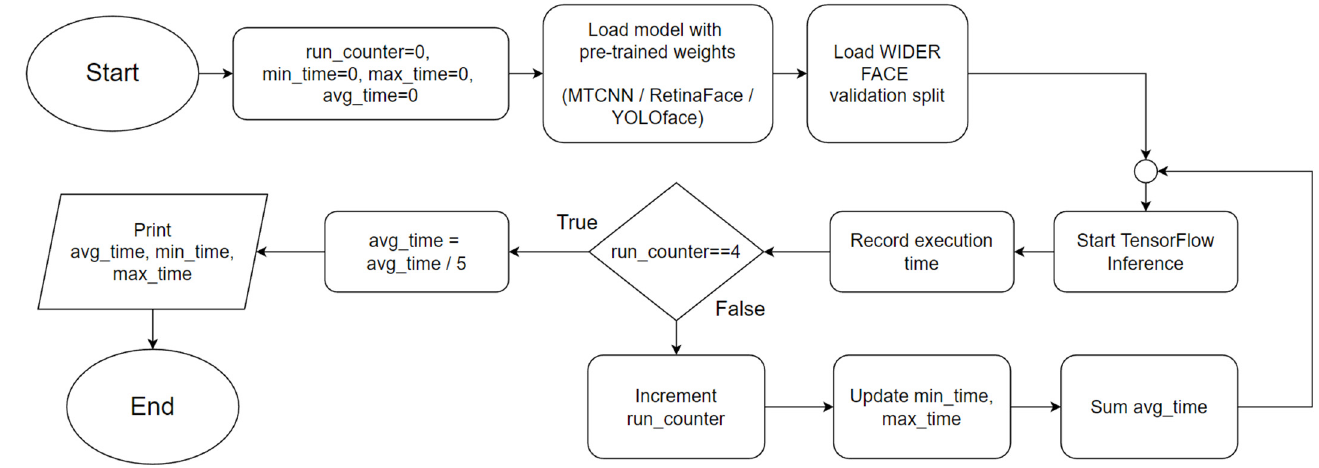
Figure 2. General flowchart for the Python programs used in Experiment 2.